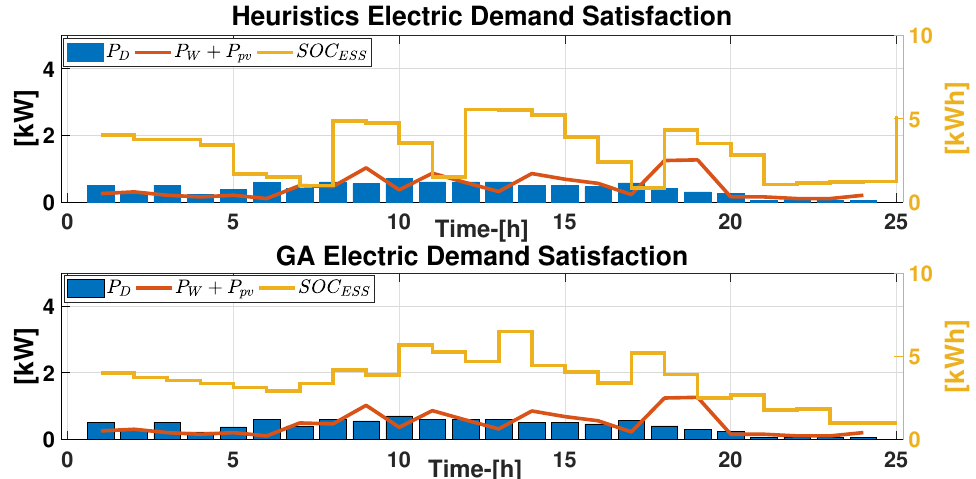
Figure 14. Heuristics and GA electric demand satisfaction numerical results.